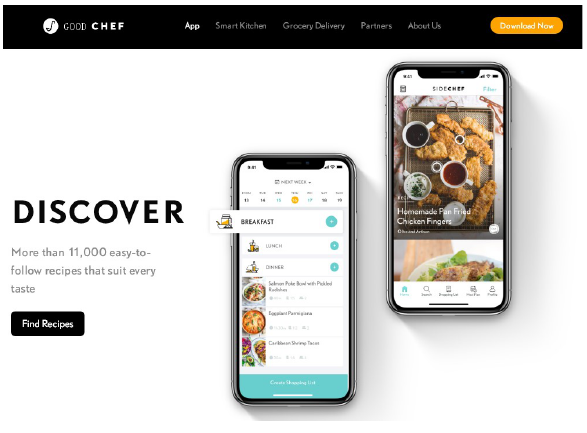
Figure 2. Good Cook Online